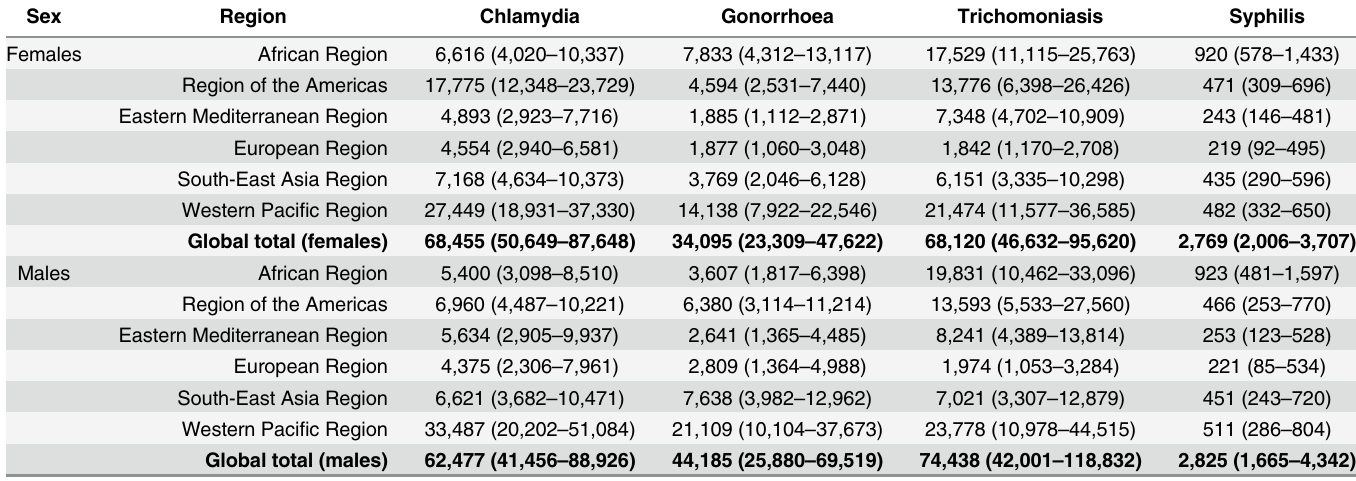
Table 6. Global and regional estimates of the number of incident cases (in thousands) in 2012 by infection and sex (95% uncertainty interval shown in parentheses).